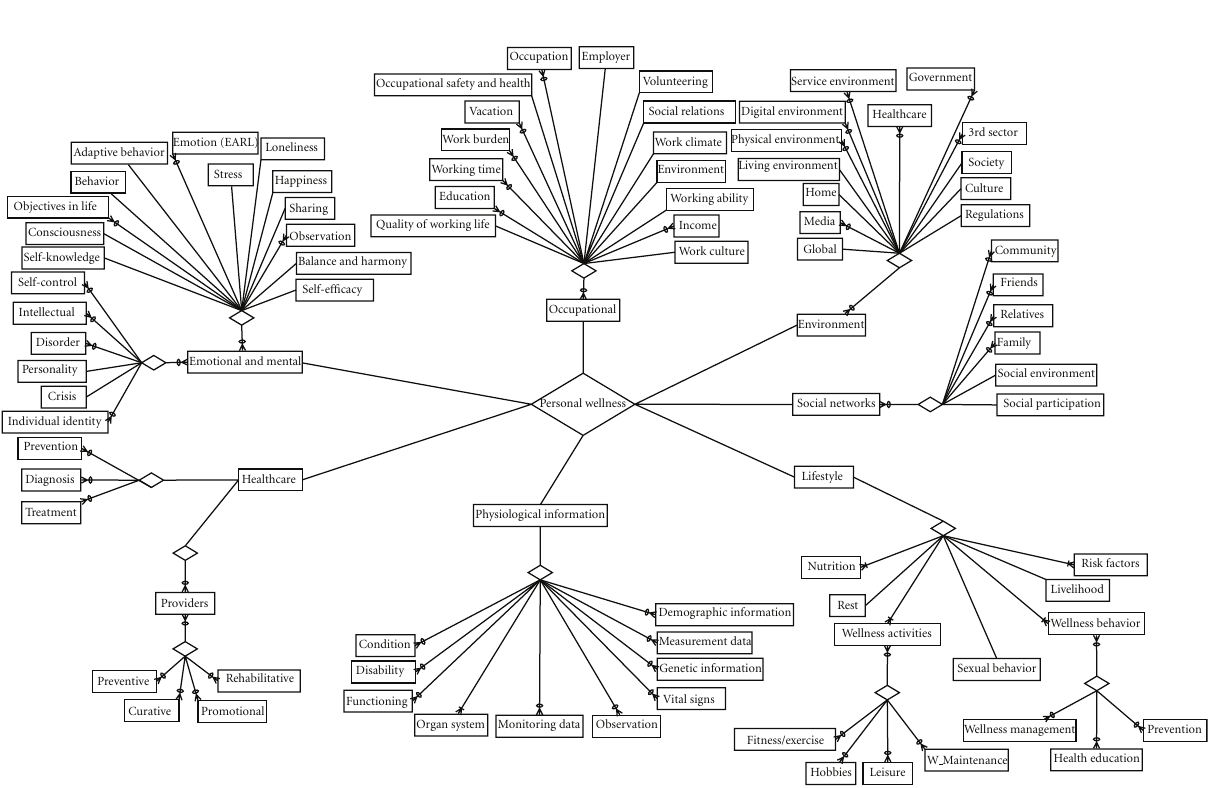
Figure 4: The highest level concepts of personal